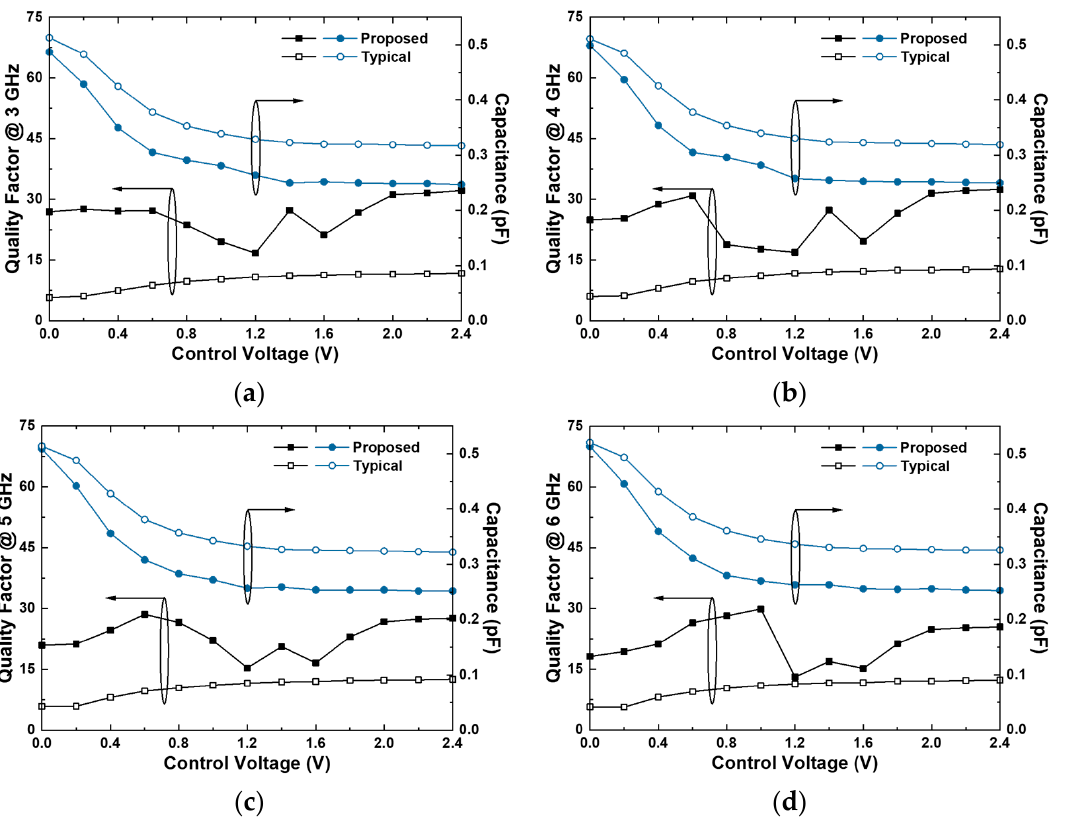
Figure 7. Measured quality factor and capacitance of typical and proposed varactors: ( a ) 3 GHz, ( b ) 4 GHz, ( c ) 5 GHz, and ( d ) 6 GHz.